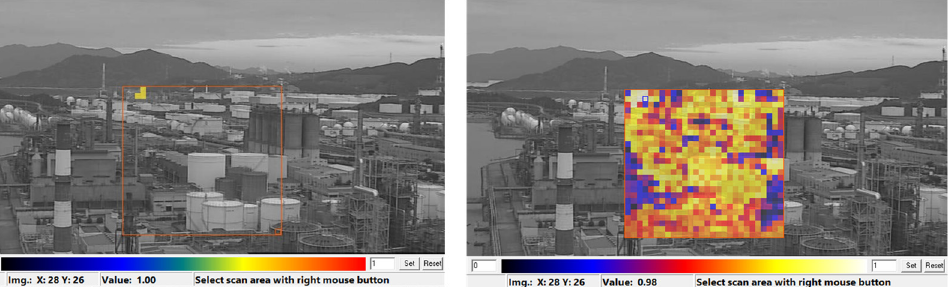
Figure 10. The identification image ( left ) and the coefficient of correlation image ( right ) for a case in which vinyl chloride was detected by the SIGIS-2 installed at the Jeongnyang site. (Date: 20 September 2022 at 18:07 GMT+9).